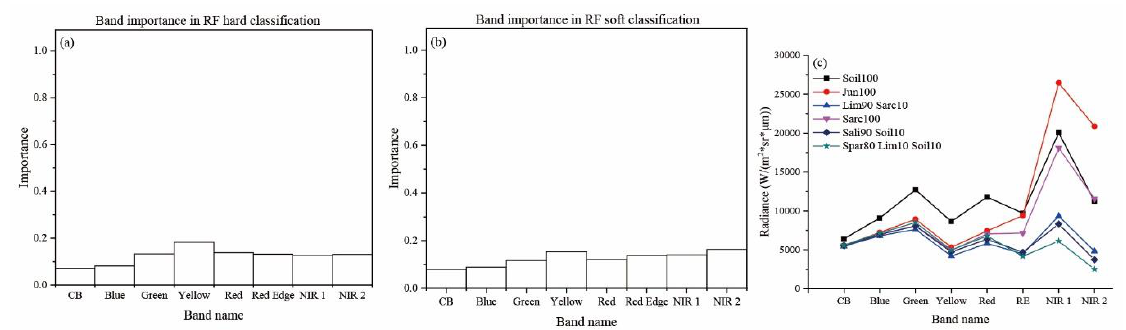
Figure 10. Band importance for di ff erent methods and reflectance characteristics of each class: ( a , b ) are the relative importance of each band for RF hard classification and RF soft classification, respectively; ( c ) is calculated by average radiance value of corresponding ROI (CB is Coastal Blue, RE is Red Edge). Table 6. Feature importance of each band in RF regression (CB is Coastal Blue). Jun = Juncus , Lim = Limonium , Sali = Salicornia , Sarc = Sarcocornia and Spar = Spartina . Band